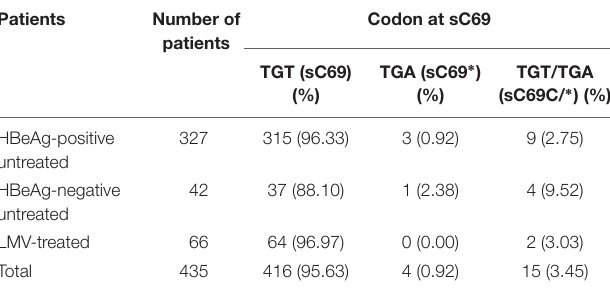
TABLE 2 | The prevalence of sC69 ∗ in HBV